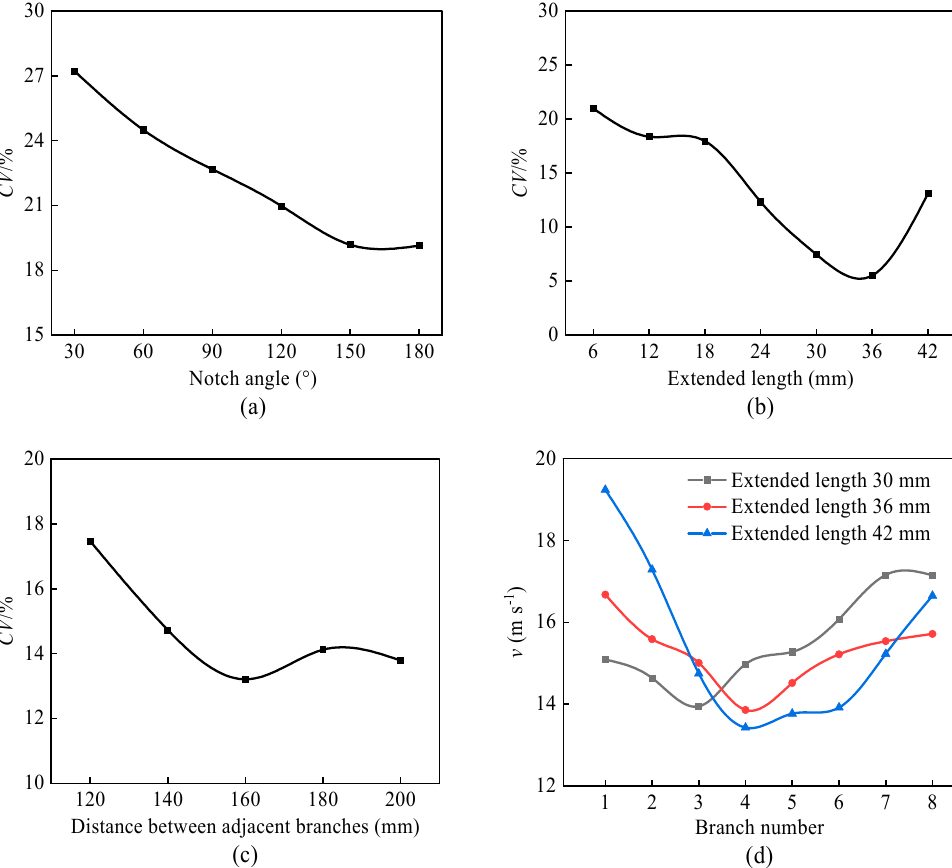
Figure 6. Effects of the three factors on CV : ( a ) Effect of the notch angle, ( b ) effect of extended length, ( c ) effect of distance between adjacent branches and ( d ) effect of extended length 30 − 42 mm on CV . The Y axes of ( a – c ) represent the coefficient of variation of the consistency of the sectional gas velocities in the different rows and the Y axis of ( d ) represents the sectional gas